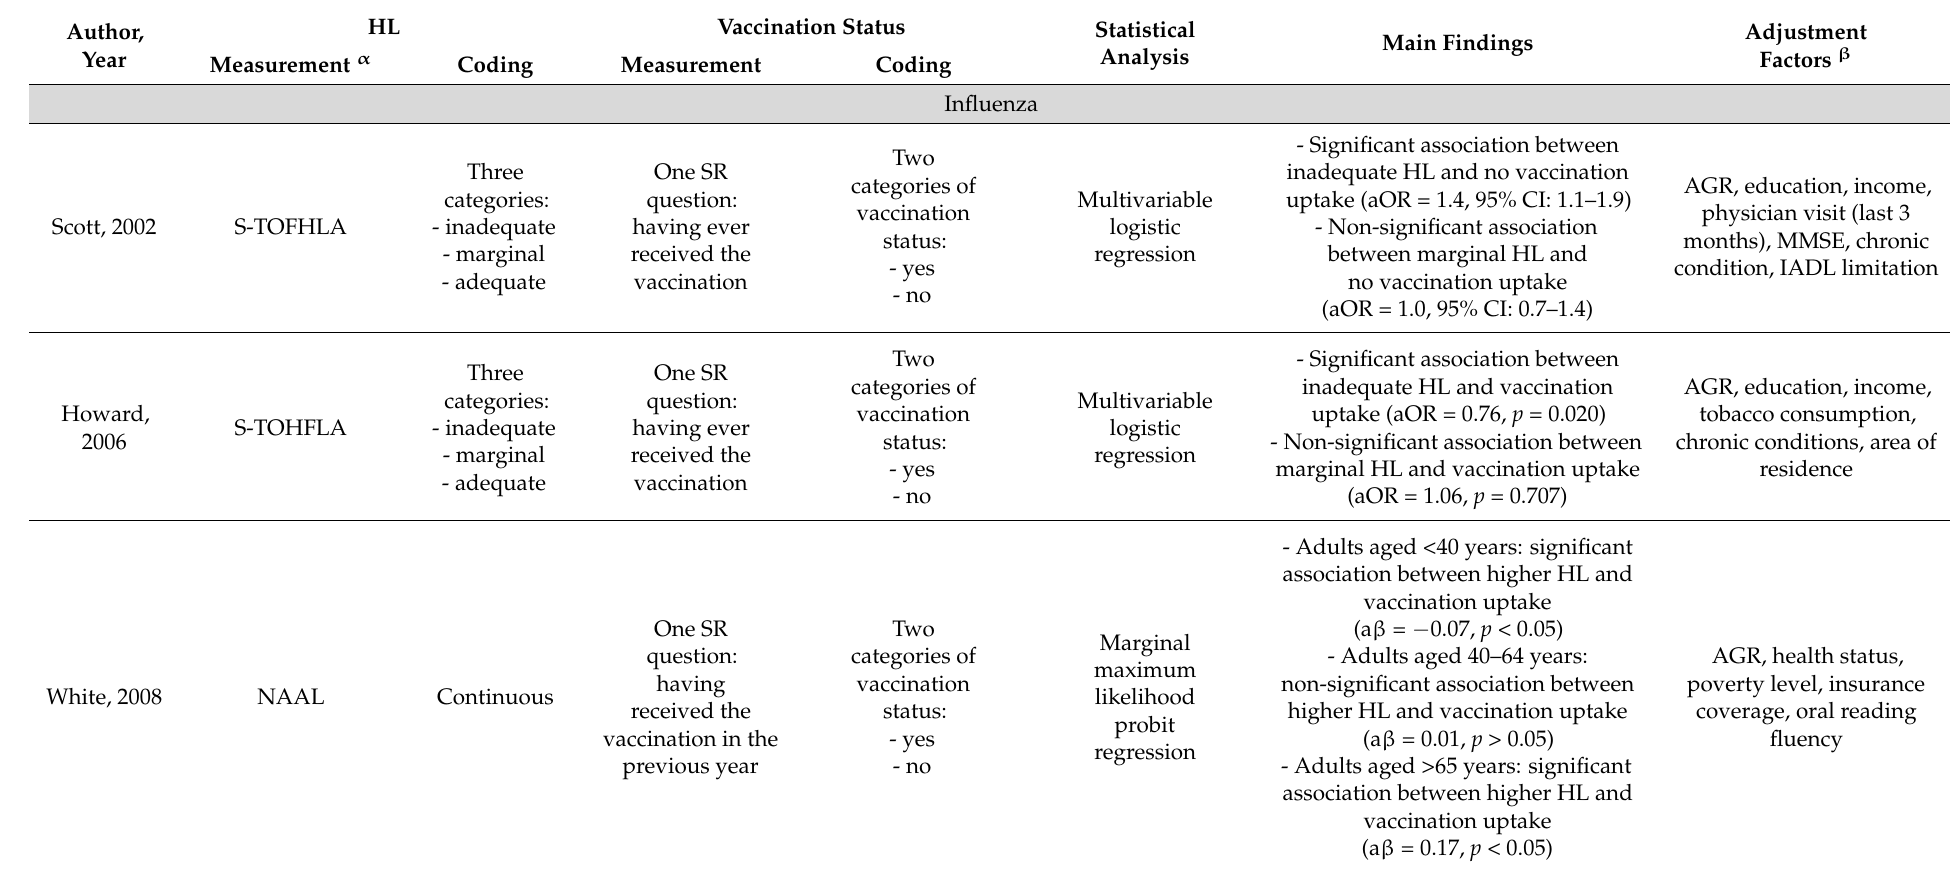
Table 4. Association between health literacy (HL) and vaccination status by vaccine